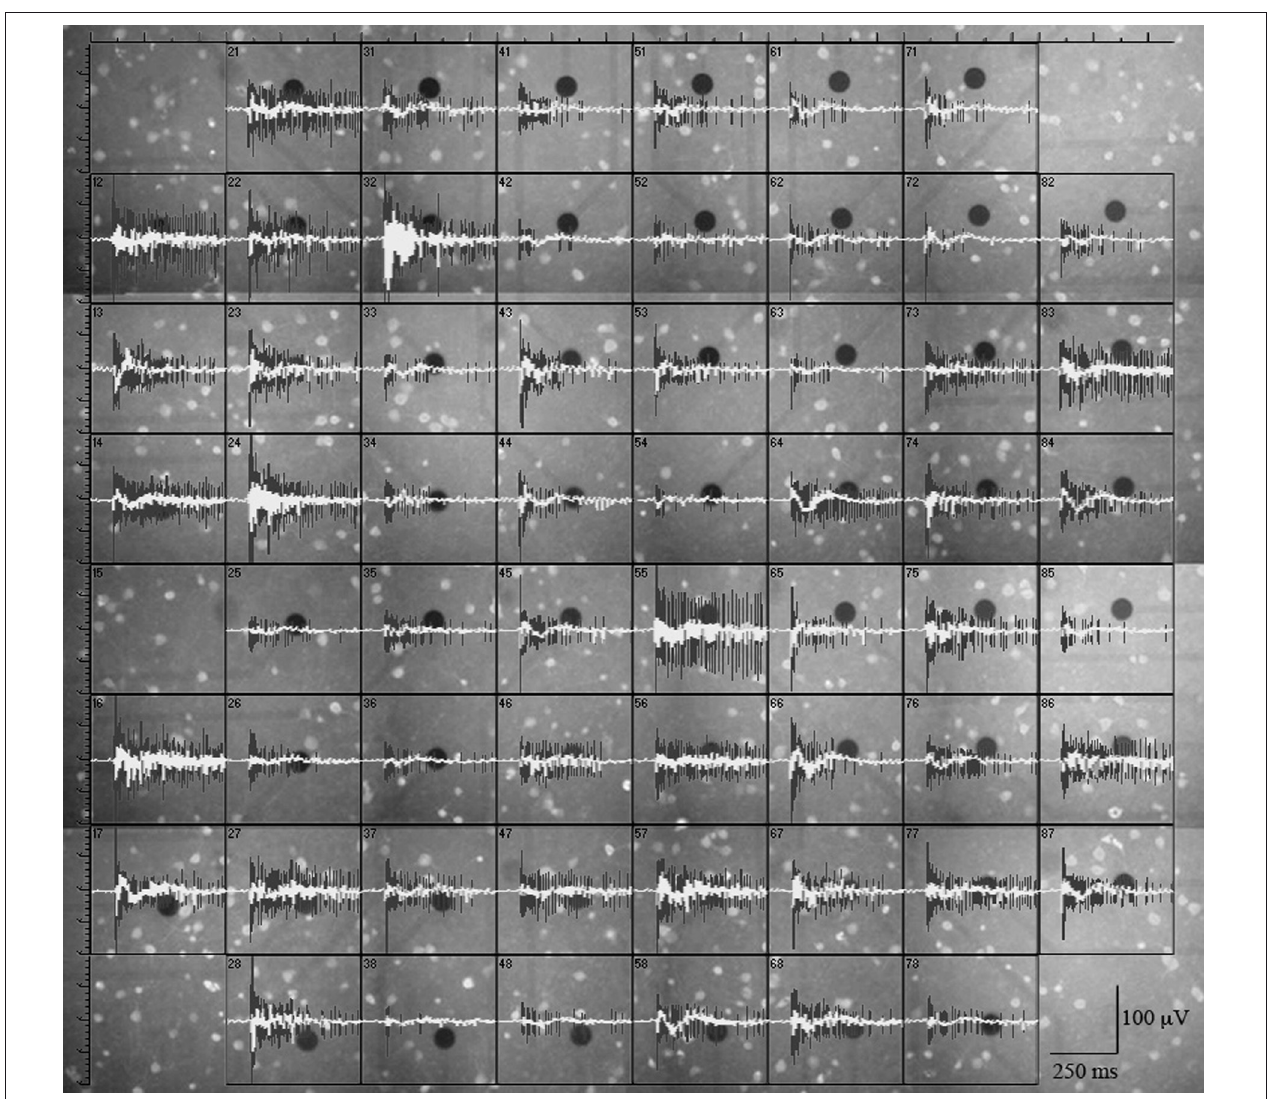
FIGURE 1 | GFP + cells and burst-related extracellularly recorded traces (spikes and local field potentials) from a representative experiment. Black circles are metal electrodes (30 μ m diameter); fluorescent spots are